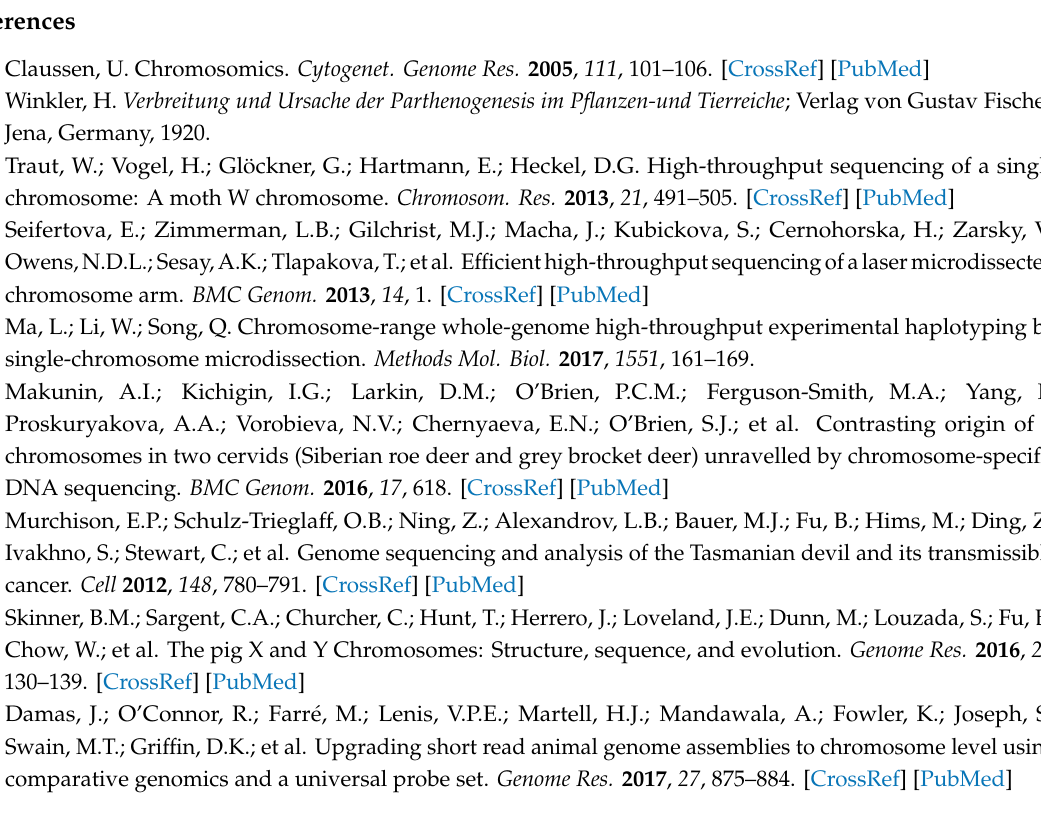
Table S1: Examples of research questions answered with a chromosomics